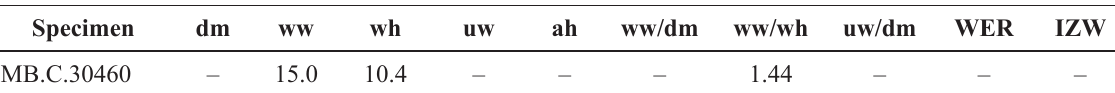
Table 7. Conch dimensions (in mm) and ratios of Stroboceras